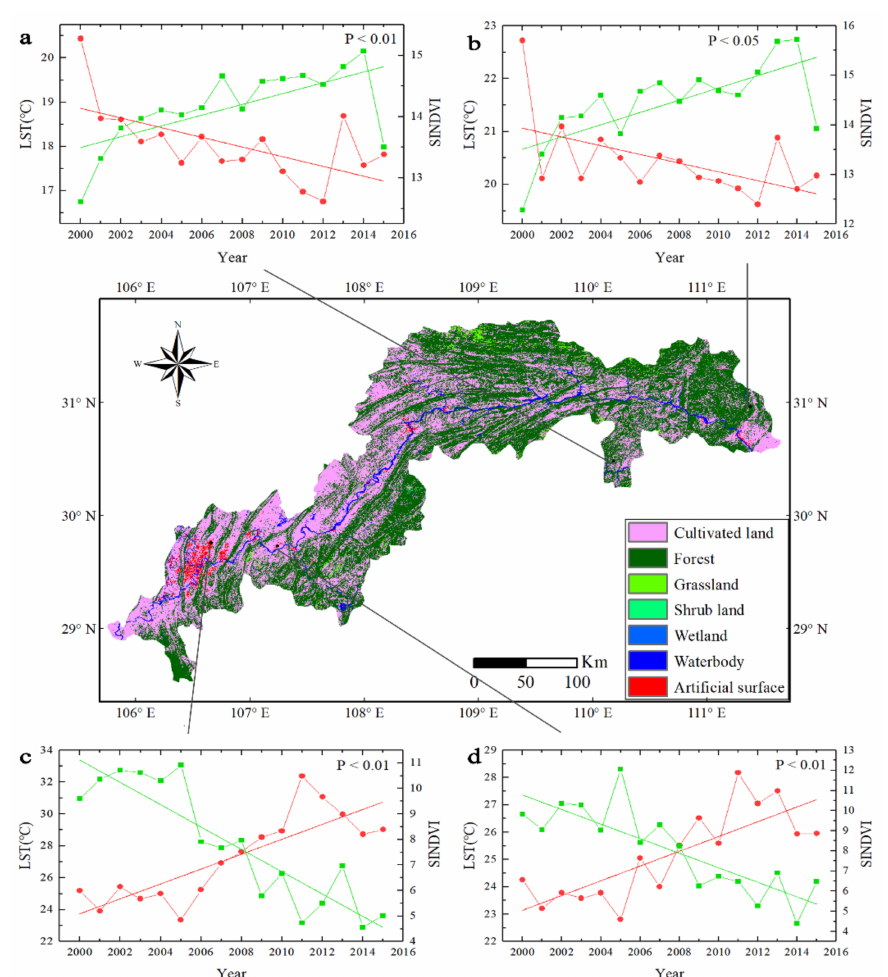
Figure 12. Time series change of the SINDVI (the green line) and LST (the red line) in four regions in the TGRC. The solid lines in green and red are the linear regressions of the time series data. The P values between the two specified variables are displayed in the upper right corner of each diagram box. The middle diagram is the land use map from 2015. The time series changes are the regional average values of grid cells area (1 km × 1 km). ( a ) Forest (30.48 ◦ N, 110.18 ◦ E). ( b ) Forest (30.96 ◦ N, 111.38 ◦ E). ( c ) Artificial surface (29.76 ◦ N, 106.65 ◦ E). ( d ) Artificial surface (29.73 ◦ N, 107.24 ◦